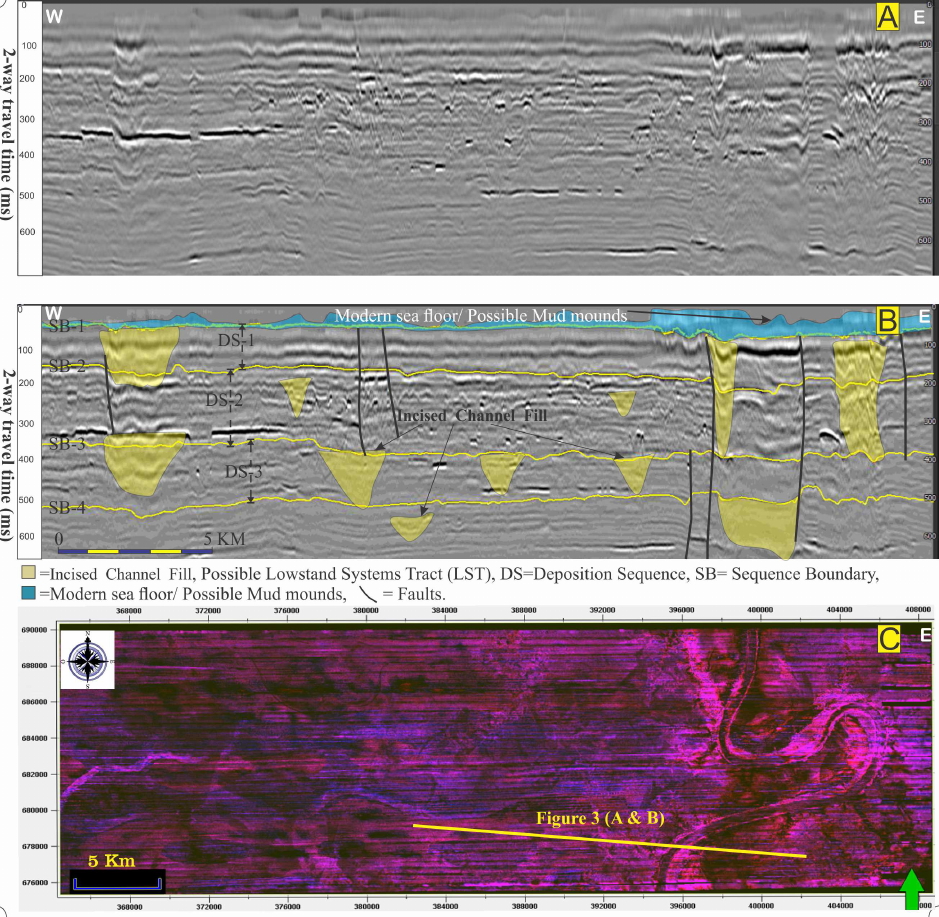
Figure 3. ( A ) The noninterpreted and ( B ) interpreted two-dimensional (2D) high-resolution seismic sections representing three major depositional sequence stratigraphy units in the uppermost − 507 ms (522–550 MTVDSS), several depositional geometries are displayed in the 2D section and ( C ) a map- view of the studied fields show the shallowest fluvial channels and incised